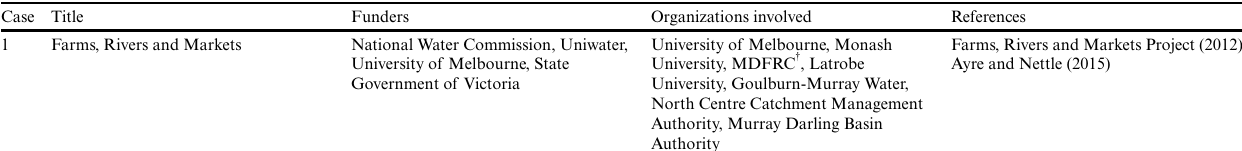
Table 2. Cases used to study collaboration in sustainable freshwater management